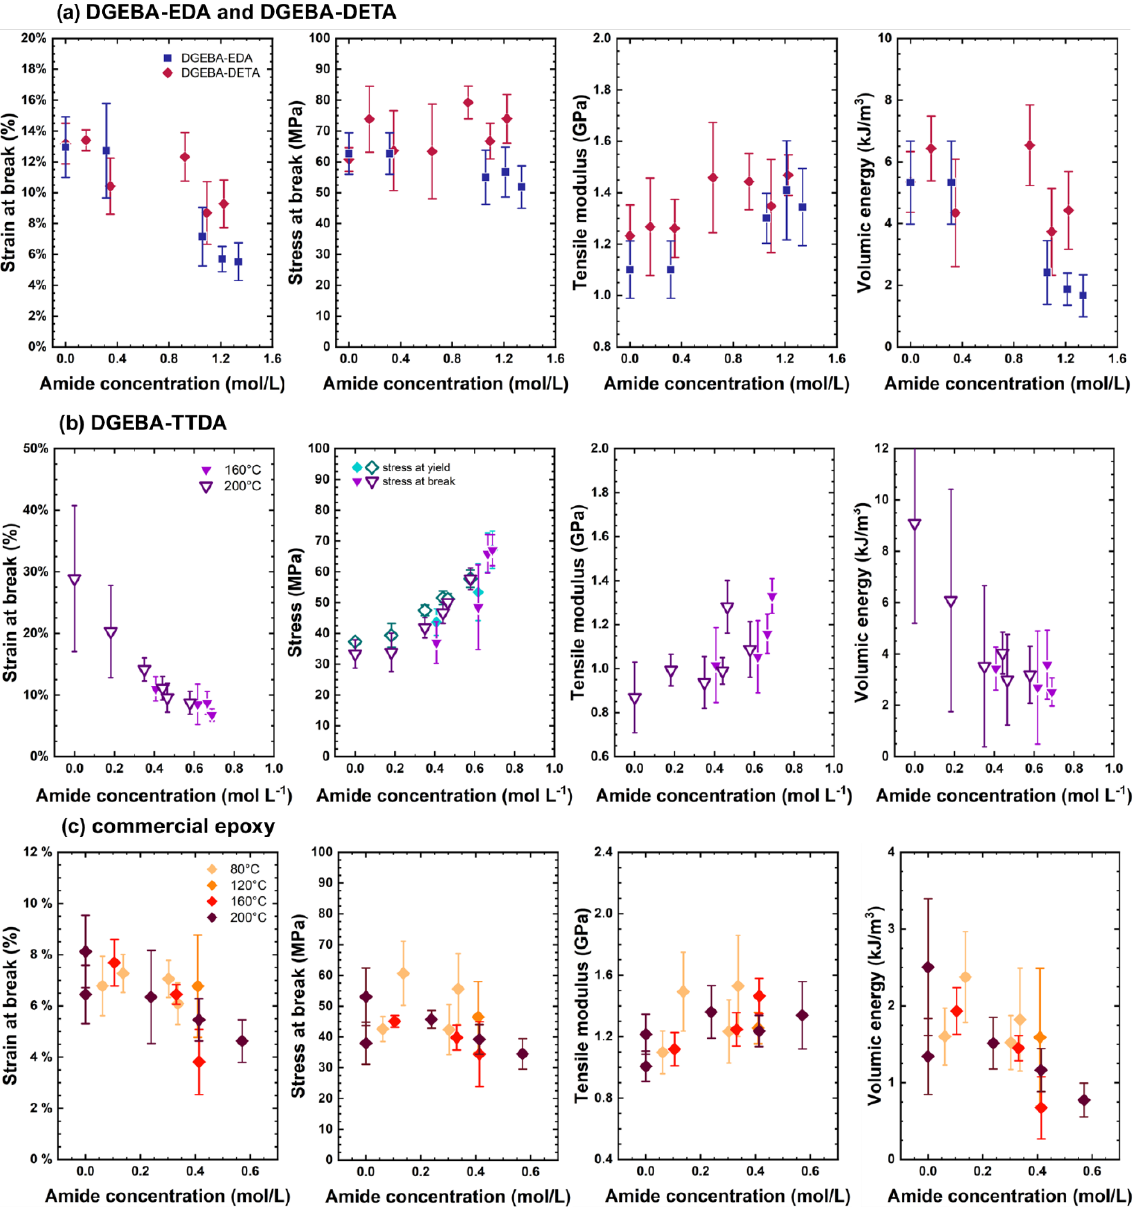
Figure 7. Structure properties involved in the degradation induced embrittlement of DGEBA-TTDA ( a ), DGEBA-EDA and DGEBA-DETA ( b ) and industrial epoxies ( c ). ( a ), DGEBA-EDA and DGEBA-DETA ( b ) and industrial epoxies ( c